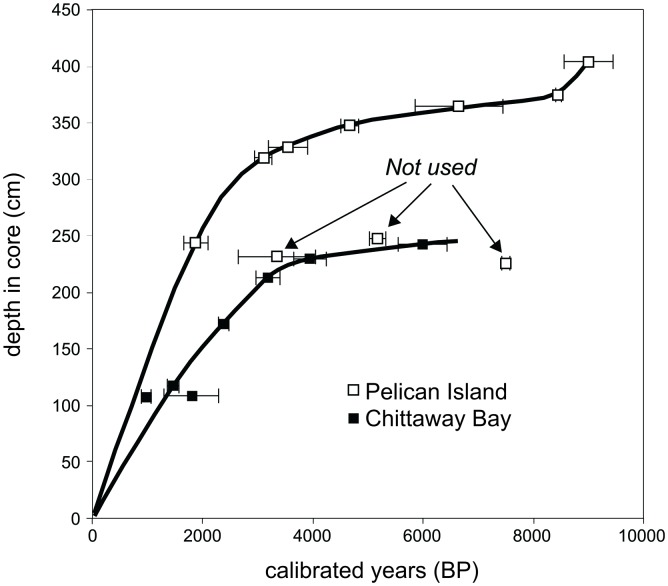
Age-models of sediment accumulation rates.